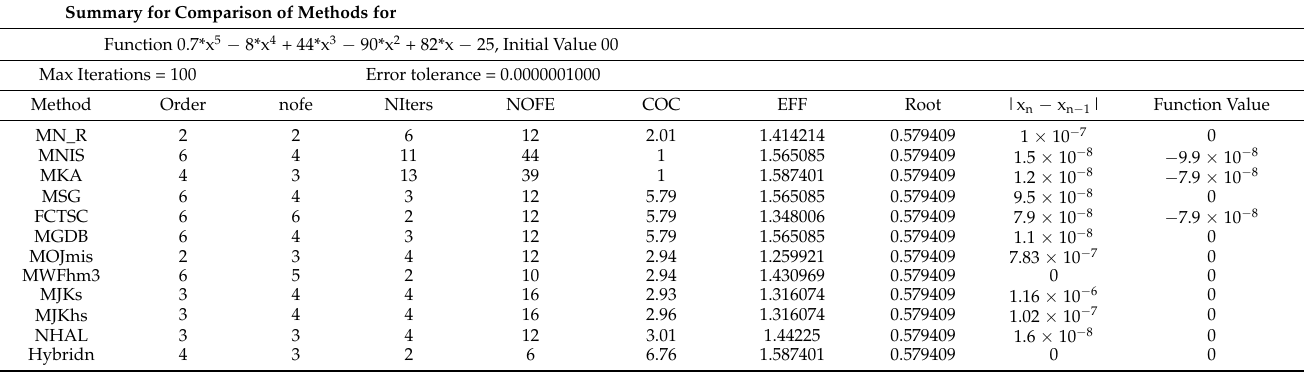
Table 4. All Parameters highlighting computational order of convergence (COC). Comparison of hybrid and all algorithms on all parameters used for the solution for another function.